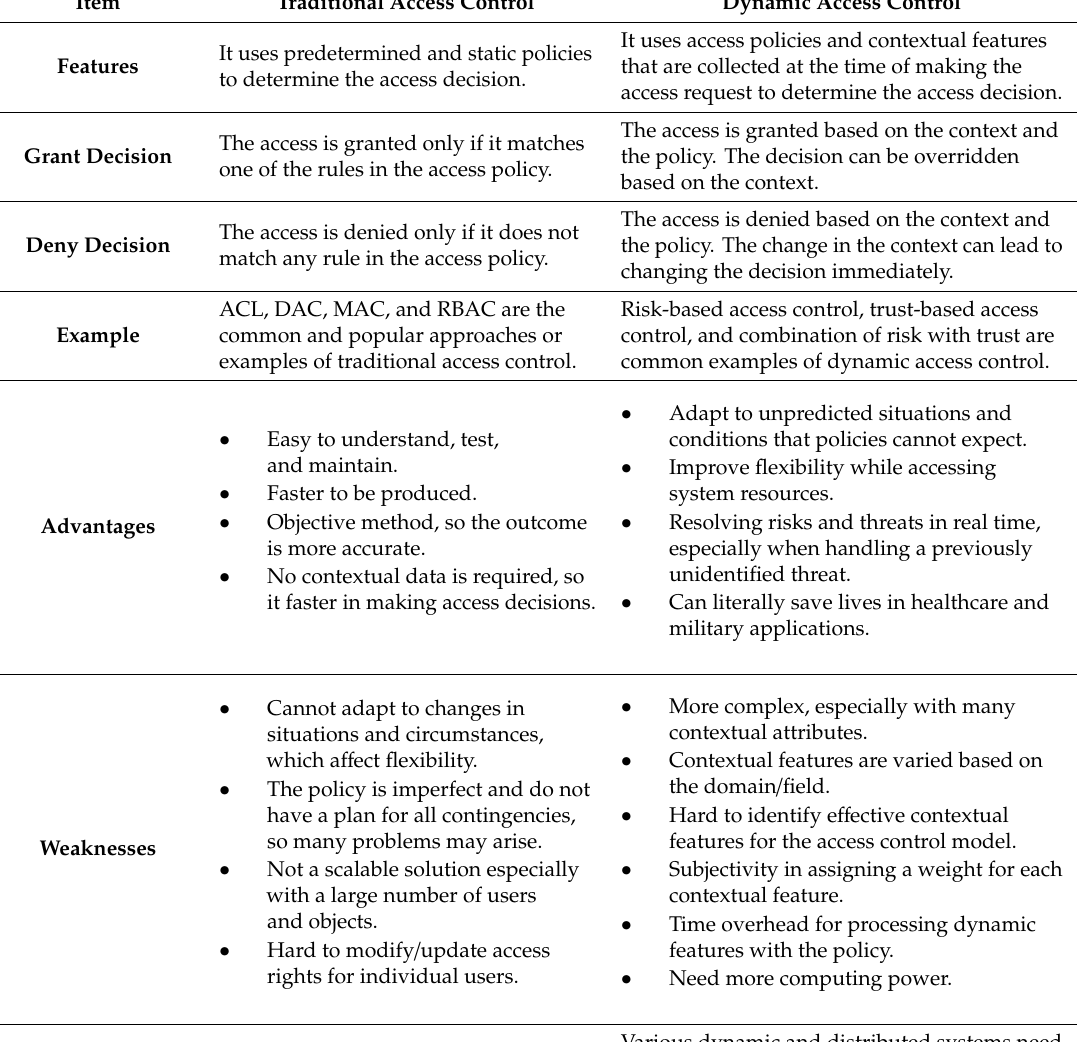
Table 1. Comparison between traditional and dynamic access control approaches. ACL: Access Control List, DAC: Discretionary Access Control, IoT: Internet of Things, MAC: Mandatory Access Control, and RBAC: Role-Based Access